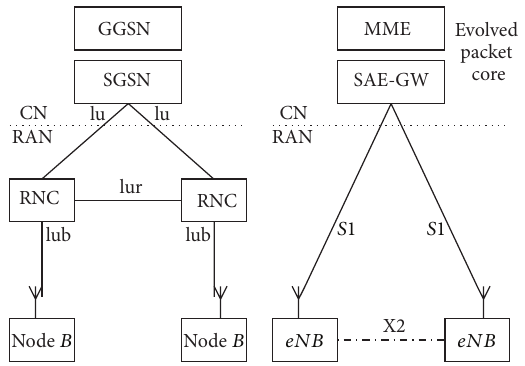
Figure 1: The RAN evolution from 3G to